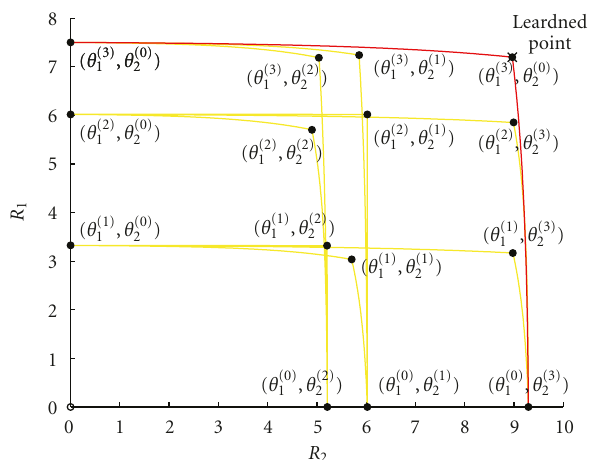
Figure 9: Crystallized rate regions in the noise-limited case with marked learned point.